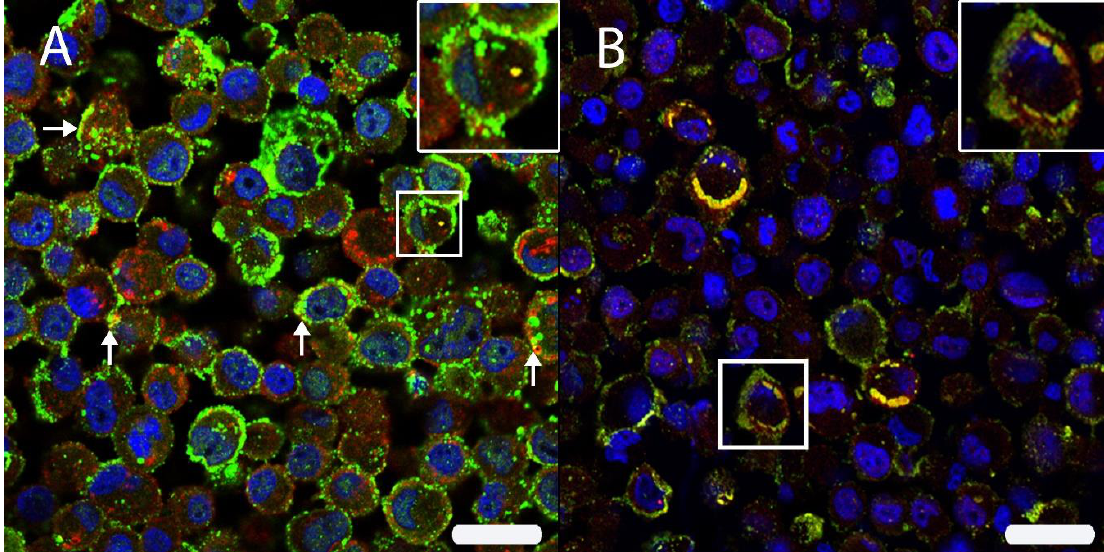
Figure 6. ( A ) The intracellular HIF-1α localization was analyzed by double immunofluorescence with HIF-1α (Cy2, green) and CD63 (Cy3, red) in persistently canine distemper virus (CDV)-infected DH82 cells. Both proteins were localized within cell membranes and cytoplasm. Interestingly, an occasional co-expression (yellow) was noted (arrows; insert) using scanning confocal laser microscopy. ( B ) A double labeling directed against HIF-1α (Cy3, red) and the CDV nucleoprotein (CDV-NP; Cy2, green) revealed a frequent co-localization (yellow) beneath the cell membrane and within the perinuclear area (insert) of persistently CDV-infected DH82 cells. Nuclei were stained with bisbenzimide (blue). Bar = 20 µm.